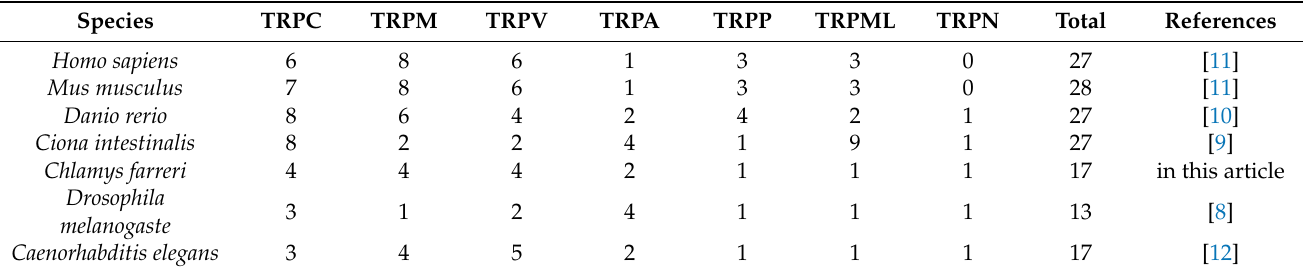
Table 1. Statistical table of gene members of TRP subfamily in different